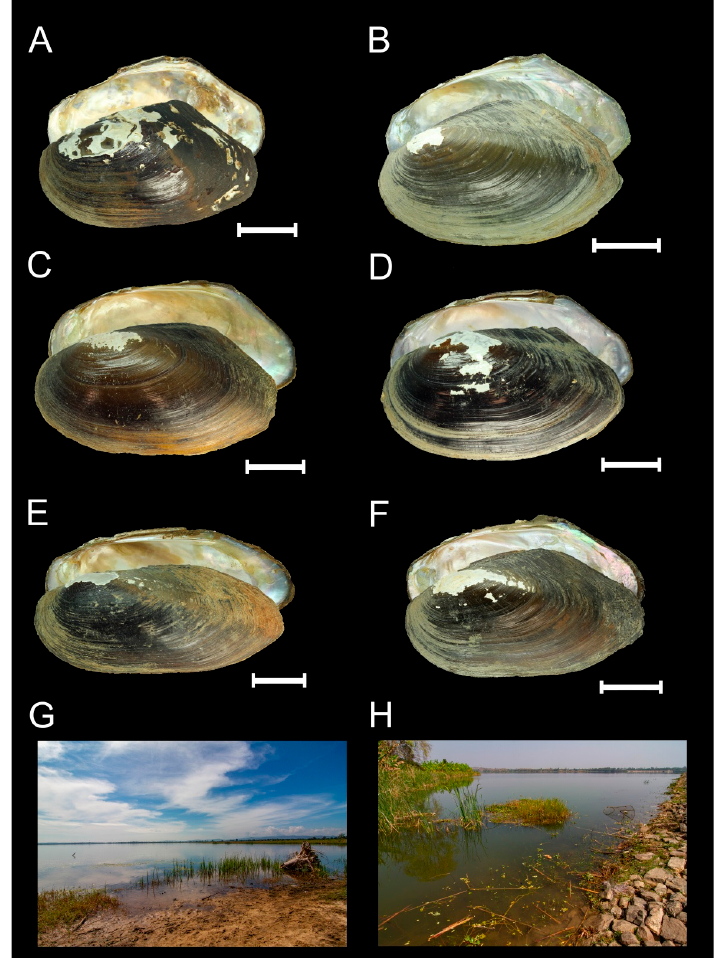
Figure 3. Hosts and type localities of the new mussel-associated mite species from the subgenus Myanmaratax subgen. nov. from Myanmar. ( A ) Shell of Lamellidens savadiensis (Nevill, 1877) (speci- men RMBH biv603_6), host of U. ( My. ) savadiensis subgen. and sp. nov. , Indaw Lake, Ayeyarwady River basin. ( B ) Shell of L. generosus (Gould, 1847) (specimen RMBH biv359_3), host of U. ( My. ) savadiensis subgen. and sp. nov. , a tributary of the Haungthayaw River. ( C ) Shell of L. savadiensis (specimen RMBH biv413_3), host of U. ( My. ) generosa sp. nov. , Sin Thay Dam, Sittaug River basin. ( D ) Shell of L. generosus (specimen RMBH biv392_2), host of U. ( My. ) generosa sp. nov. , Pagaing Stream, Sittaug River basin. ( E ) Shell of Trapezidens angustior (Hanley and Theobald, 1876) (speci- men RMBH biv388_3), host of U. ( My. ) trapezidens sp. nov. , Kyauk Phar Stream, Bago River basin. ( F ) Shell of T. dolichorhynchus (Tapparone Canefri, 1889) (specimen RMBH biv442_1), host of U. ( My. ) trapezidens sp. nov. , Ayeyarwady River. ( G ) Type locality of U. ( My. ) savadiensis subgen. and sp. nov. ( H ) Type locality of U. ( My. ) generosa sp. nov. (Photos: Ekaterina S. Konopleva ( A – F ) and Ilya V. Vikhrev ( G , H